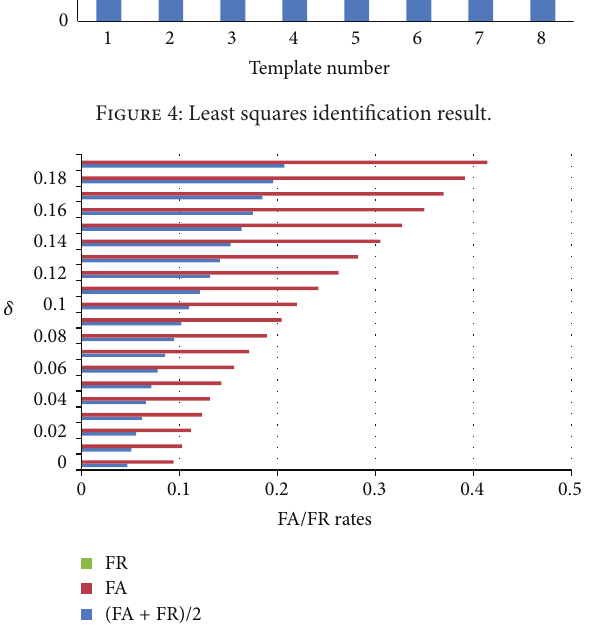
Figure 5: FA and FR